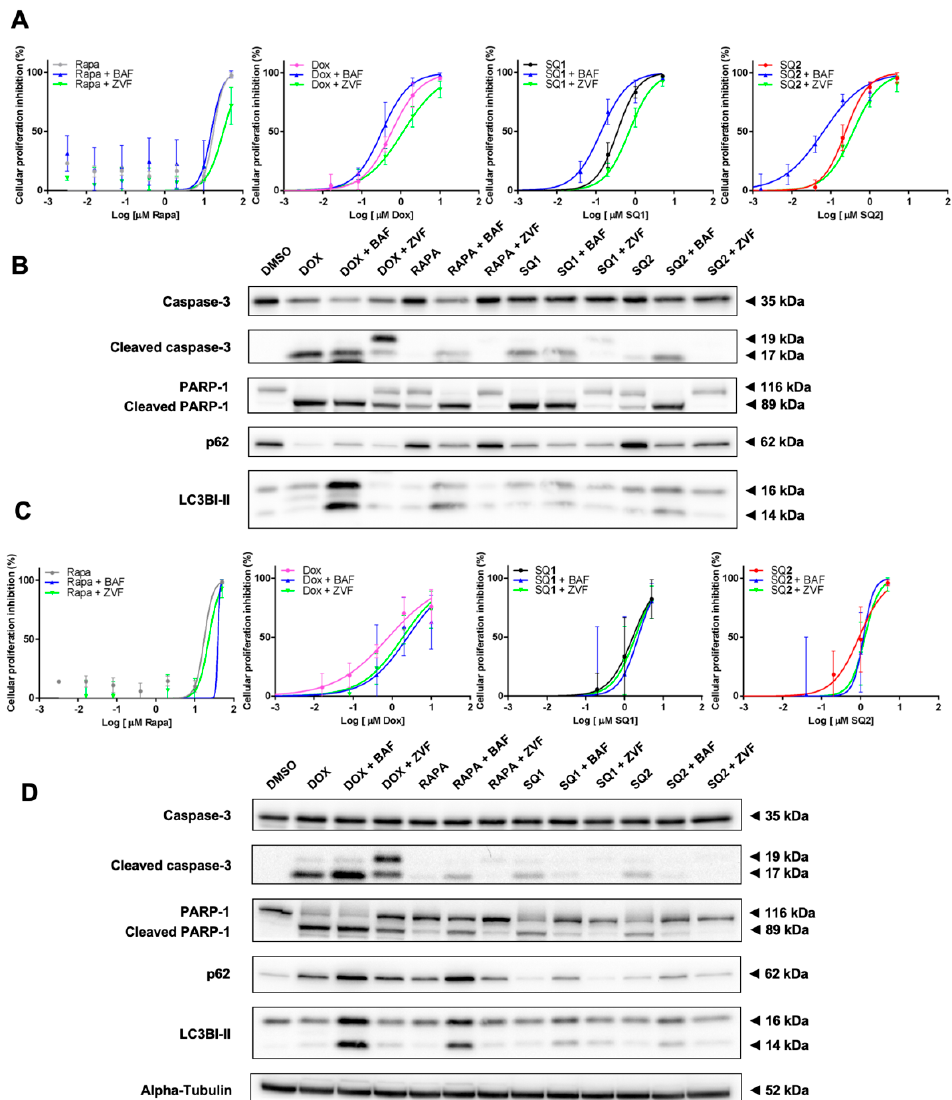
Figure 5 . BRAF and NRAS respond differently under inhibition of the autophagy signaling. SK-MEL-28 ( A , B ) and SK- MEL-147 ( C , D ) cells were submitted to 1-h pre-treatments with 30 nM bafilomycin A1 (BAF) or 20 µM Z-VAD-FMK (ZVF). Dose-response curves ( A – C ) were calculated using the MTT assay with increasing concentrations of SQ1 and SQ2 following 24-h treatment (n = 3; mean ± SD). Protein expression ( B – D ) (PARP-1, cleaved PARP-1, caspase 3 and cleaved caspase 3, p62, and LC3B) was evaluated by Western blotting after 24 h of incubation with: DMSO (negative control: 0.2%), doxorubicin (DOX; positive control: 1.4 µM for SK-MEL-28 and 0.8 µM for SK-MEL-147), rapamycin (RAPA, 18 µM), SQ1 (0.6 µM for SK-MEL-28 and 1.79 µM for SK-MEL-147), and SQ2 (0.1 µM for SK-MEL-28 and 1.26 µM for SK-MEL-147). Quantifications were carried out in the UN-SCAN-IT Gel 6.1 (Silk Scientific), normalized by α -tubulin and compared with the negative control of each experiment (n = 3).